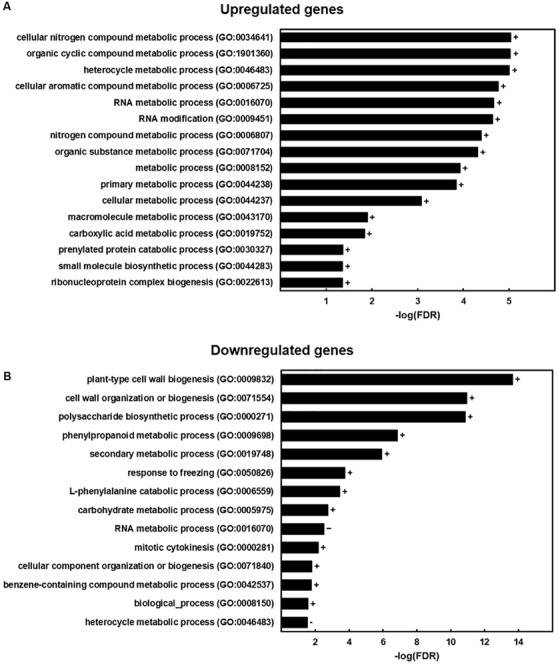
GO enrichment analysis. GO terms that were more represented in the genes with a significant change in expression of the RNA-Seq analysis (p-value < 0.05) that in N. tabacum genome. (A) Results for the group of upregulated genes (427 total genes, but 297 were assigned with a GO category and included in the analysis). (B) Results for the group of downregulated genes (354 total genes, but 274 were assigned with a GO category and included in the analysis). The figure shows the -log(FDR) for each category obtained with a Benjamini-Hochberg FDR correction. Signs next to the bars indicate if a category was overrepresented (+) or underrepresented (–) in the sample.